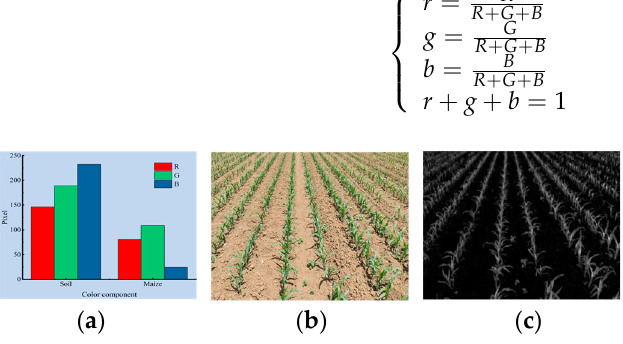
Figure 4. ( a ) Pixel histogram; ( b ) Original image; ( c ) Grayscale image.